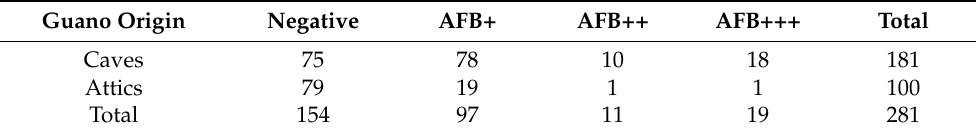
Table interpretation. ZN = microscopy examination after the Ziehl–Neelsen staining in at least 200 fields; negative = negative examination; + sporadic acid-fast bacteria (AFB) detection; ++ = few AFB present in each